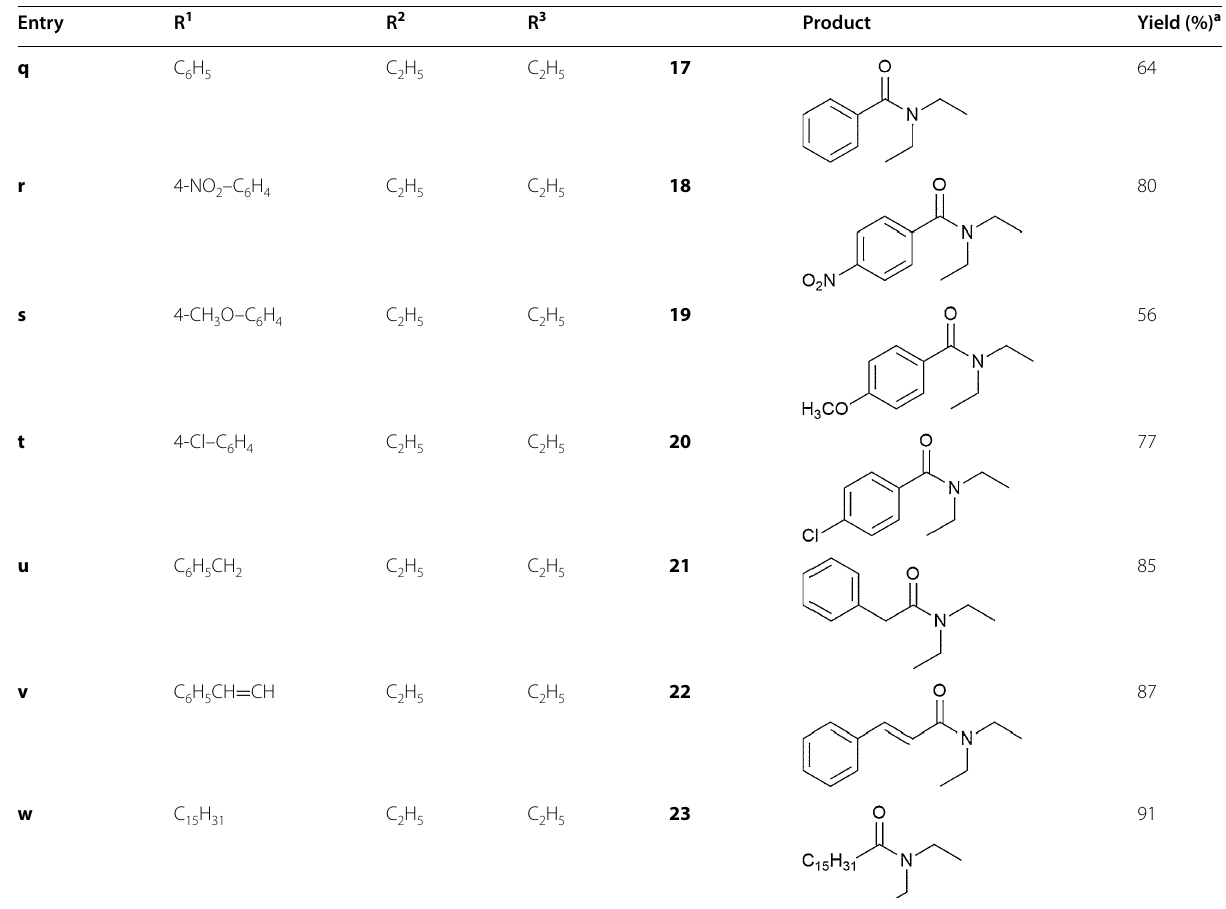
Table 4 Synthesis of N , N -diethylamides